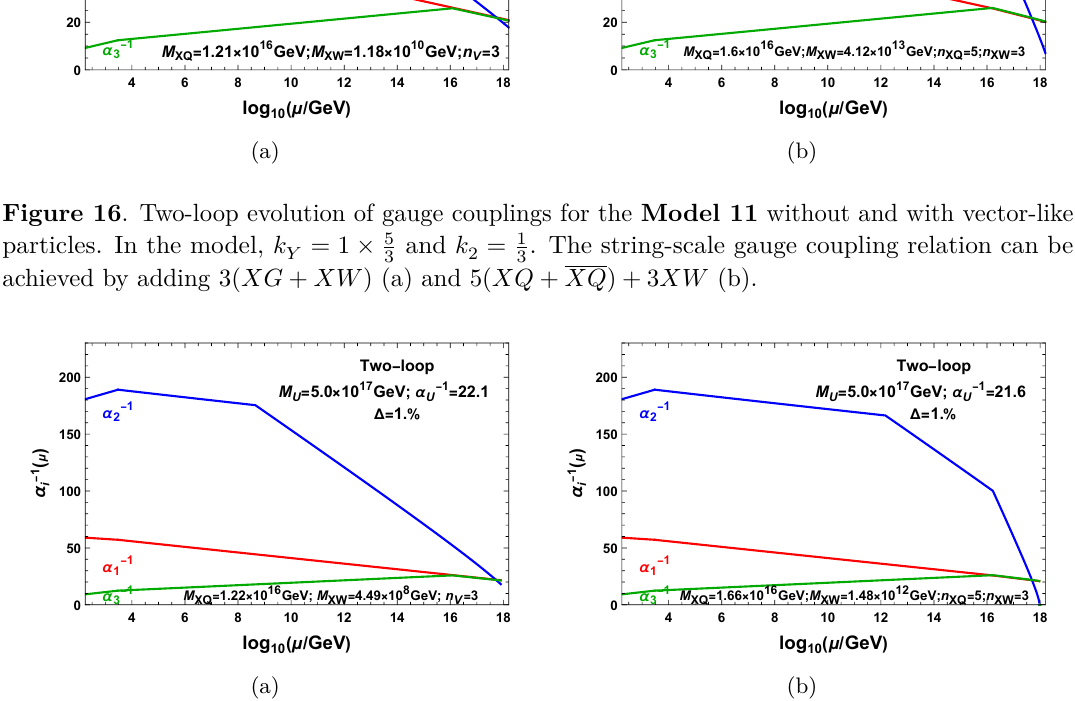
Figure 17 . Two-loop evolution of gauge couplings for the Model 12 with vector-like particles. In the model, k = 35 × 5 and k = 1 . The string-scale gauge coupling relation can be achieved by Y 2 32 3 6 adding 3( XG + XW ) (a) and 5( XQ + XQ ) + 3 XW (b).